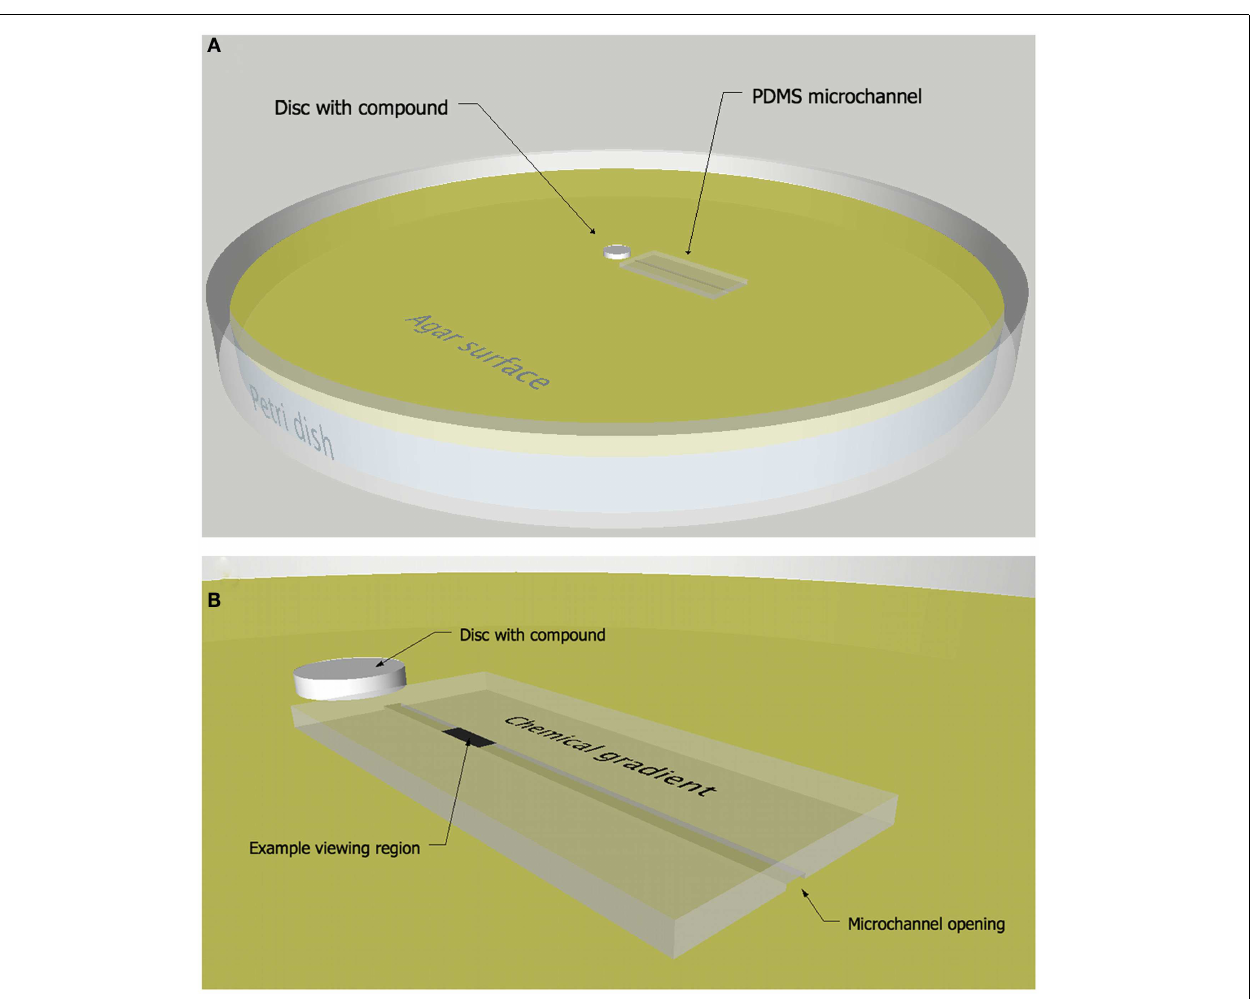
FIGURE 1 | Microchannel chemotaxis response assay. Diagram (A) and close-up (B) of the microchannel chemotaxis assay in which a PDMS microchannel was placed onto an agar surface containing a chemical gradient of compounds diffusing from a paper disk or growing colony of bacteria.